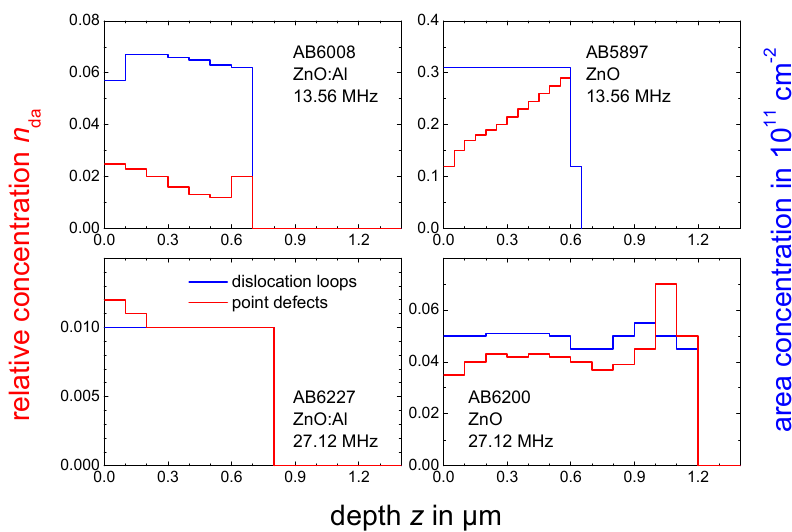
Figure 7. Depth distribution of the defect concentrations used to calculate the χ min spectra plotted in Figure 6 for the various homoepitaxial ZnO and ZnO:Al layers investigated, which are indicated in the figure. Please note the different ordinate scales in different parts of the figure.